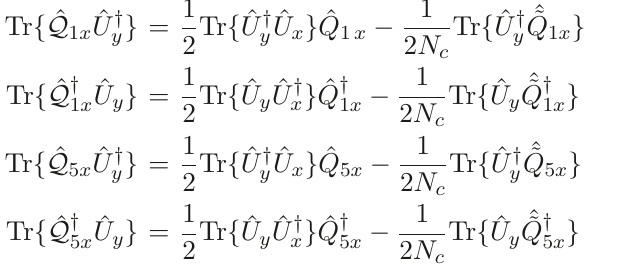
} , and Tr { ˜ Q 5 x U † y